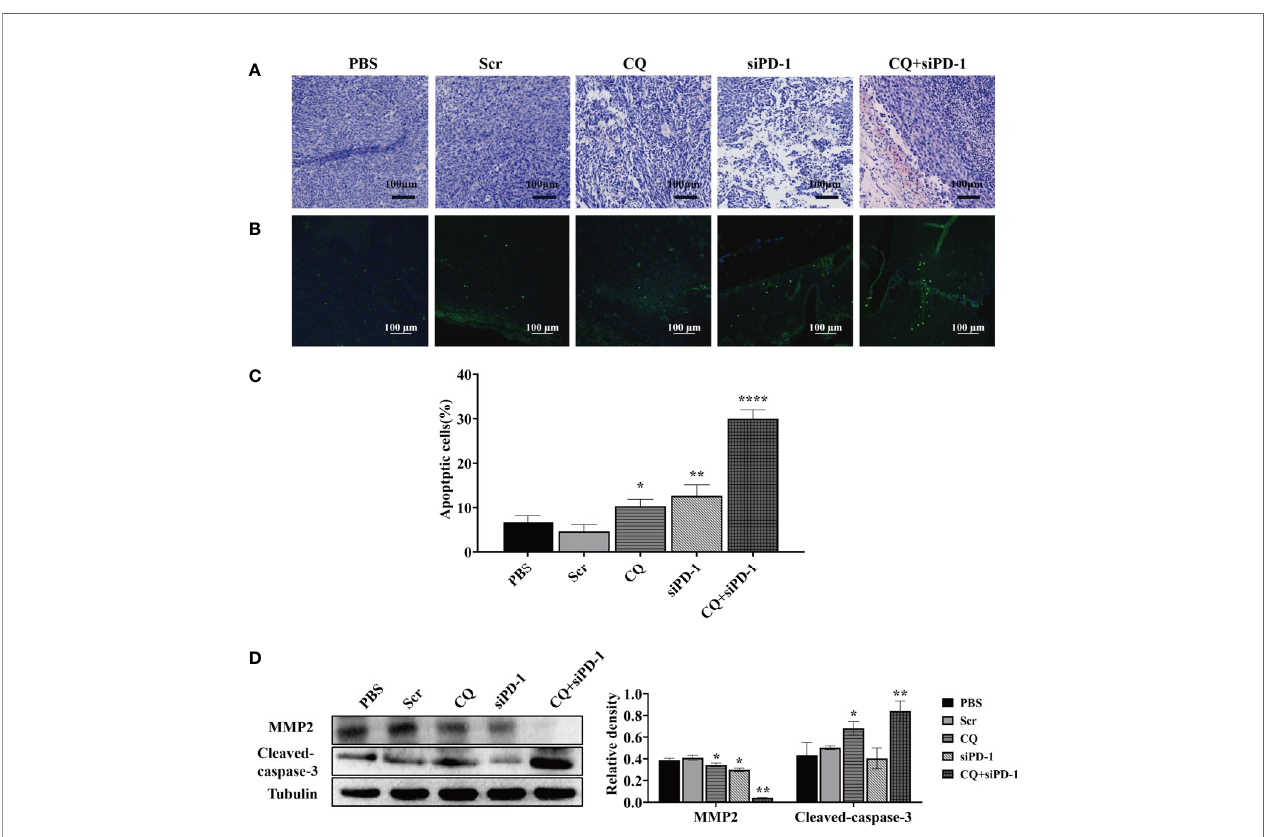
FIGURE 5 | In vivo experiments have detected that chloroquine combined with siPD-1 in the treatment of colorectal cancer can signi fi cantly inhibit the migration of colorectal cancer and promote cell apoptosis. Tumor tissues were collected on day 14 after the fi rst treatment and were subjected to HE, TUNEL staining, and Western blotting analysis. (A) Tissue HE staining. (B, C) TUNEL staining and quantitative analysis of tissues. (D) The expression of proteins associated with apoptosis and migration.(* p < 0.05, ** p < 0.01, **** p < 0.0001 vs PBS or Scr